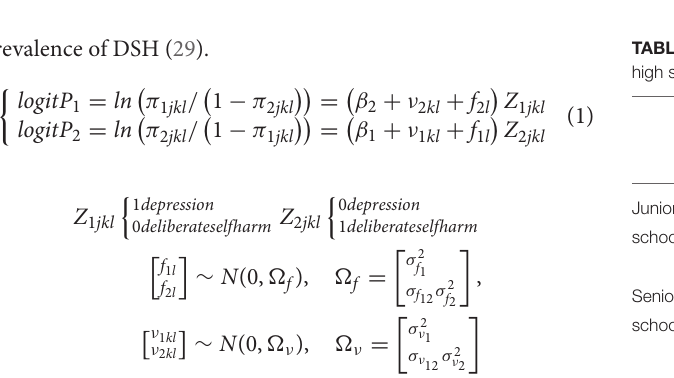
FIGURE 1 | The hierarchical structure of depression and deliberate self-harm (DSH) in rural adolescents.